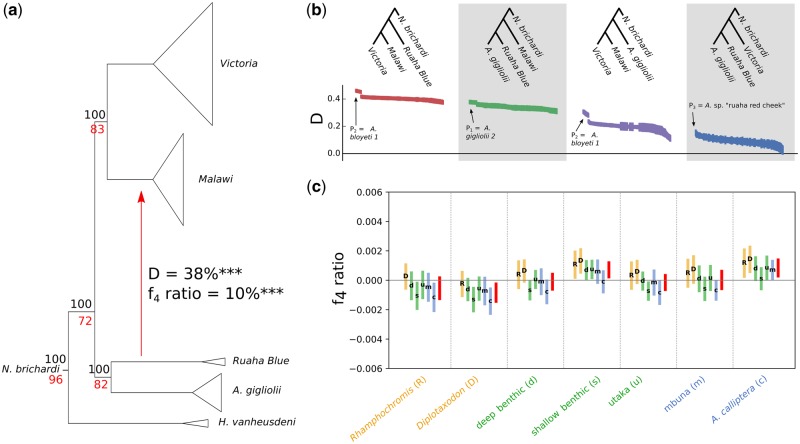
Gene flow into the common ancestor of the Malawi radiation: (a) Cladogram of major lineages. All presented clades have 100% bootstrap support in the underlying NJ tree of all samples (black numbers above nodes; fig. 1b, supplementary fig. S1, Supplementary Material online; Materials and Methods). Red numbers below nodes show the percentage of times that this node was seen among 2,010 maximum likelihood gene trees of 8,000 SNP variants each (Materials and Methods). The red arrow indicates the strongest gene flow event as inferred by Patterson’s D and f4 admixture ratio (P1 = Victoria, P2 = Malawi; P3 = Ruaha Blue, P4 = Neolamprologus brichardi) (see supplementary fig. S3 and supplementary table 2, Supplementary Material online, for all f4 admixture ratio values) (Patterson et al. 2012). ***indicates a block-jackknifing significance of P < 10−16. (b) D-tests to infer the directionality of introgression. The four regions accentuated by white and gray shading correspond to −DFI, DIL, −DOL, and DFO, respectively, in the DFOIL five-taxon test (Victoria, Malawi, Ruaha Blue, A. gigliolii, N. brichardi) (Pease and Hahn 2015), except that—as is standard for Patterson’s D—only sites were considered where P3 has the derived allele. The trees within each region show the groups from which P1, P2, P3, and P4 (from left to right) were taken for the tests below. The different data points correspond to tests for all possible combinations of samples from each of the clades. Error bars correspond to ±3 block-jackknifing standard deviations. Outlier tests are annotated with the sample they have in common. We note that the sample A. bloyeti 1 from Lake Kumba in the Pangani catchment is an outlier in many comparisons consistent with it having received genetic material not related to any other sample in our data set. (c) f4 admixture ratio tests (Patterson et al. 2012) with P3 = Victoria and P4 = Ruaha Blue. P2 is given on the x-axis and P1 by the letter in the bar. Bars and labels are colored by group microhabitat (yellow = pelagic, green = benthic, blue = littoral). The red bars correspond to the case where P1 is a group of all Malawi samples except P2. Bar height corresponds to ±3 block-jackknifing standard deviations. f4 values between Malawi subgroups in (c) are a hundred times smaller than between founders in (a).